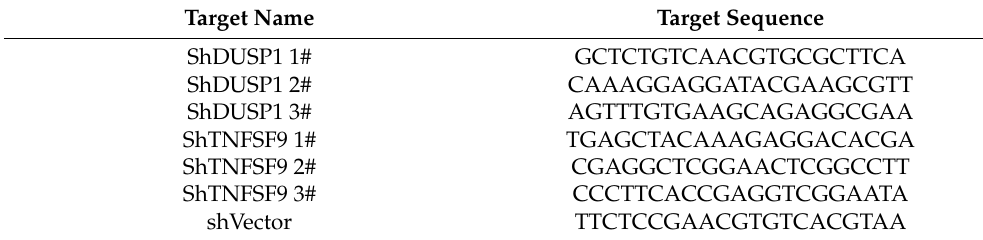
Table 3. The target site sequences were used in this study.